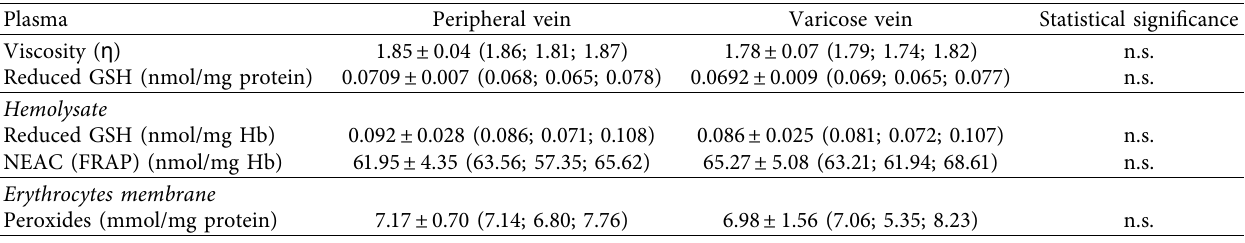
Table 2: Determined parameters of the plasma, hemolysate, and erythrocytes membrane isolated from blood obtained from peripheral vein and varicose vein blood.